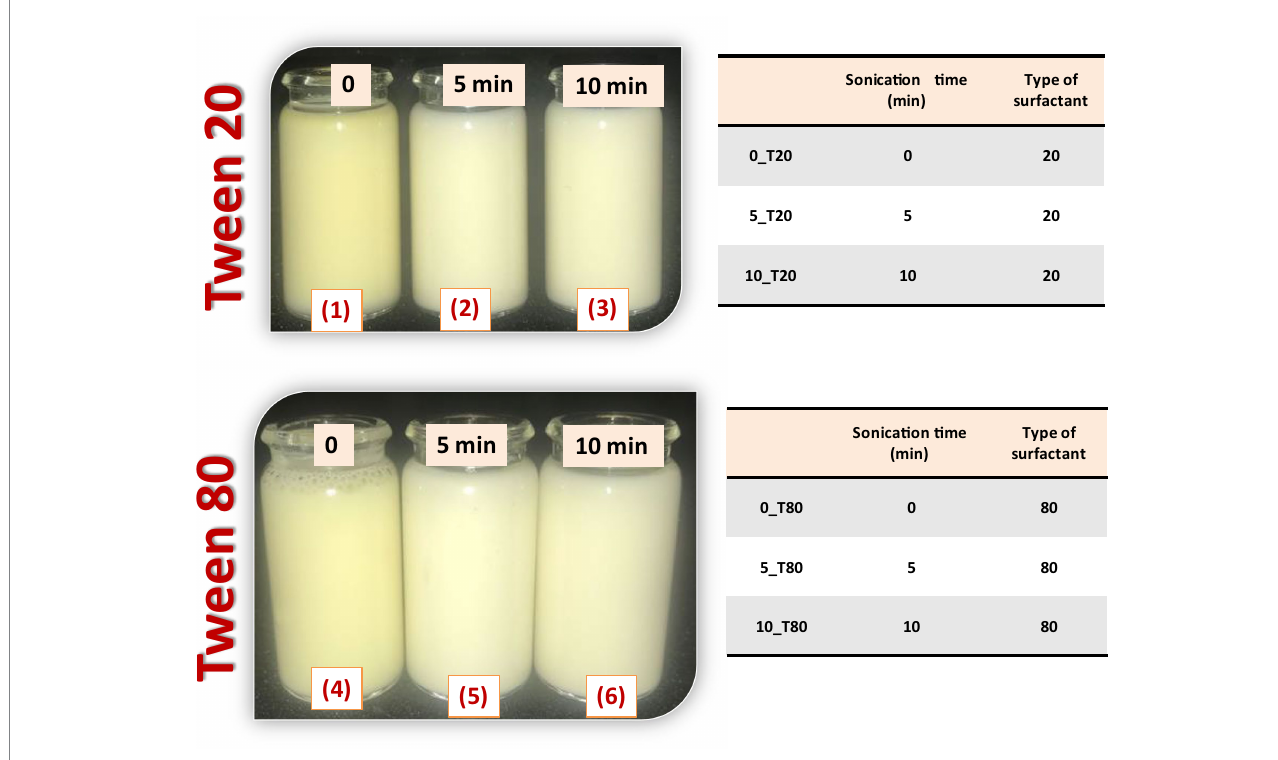
FIGURE 1 Preparation of Nigella sativa oil nanoemulsions using two types of surfactant (Tween 20 and 80) and different times of sonication (0, 5, and 10